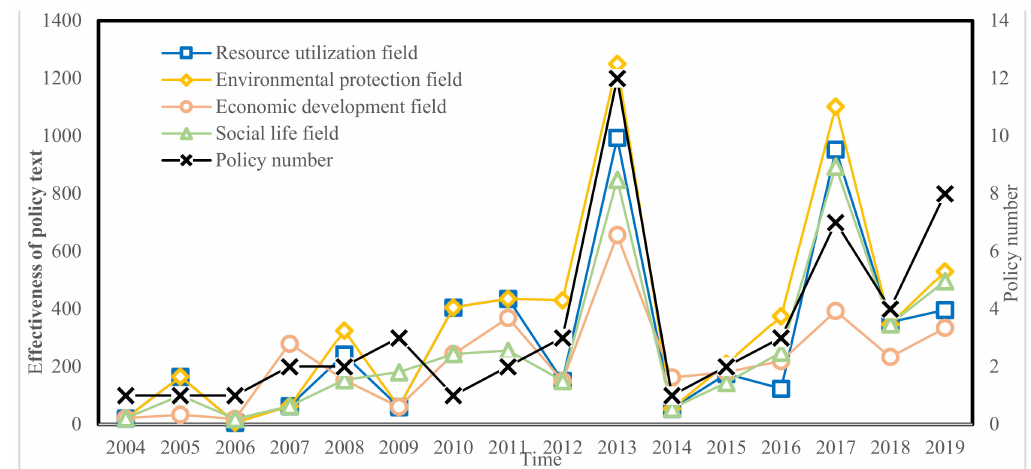
Figure 1. Effectiveness of the ecological civilization policy text from 2004 to 2019.